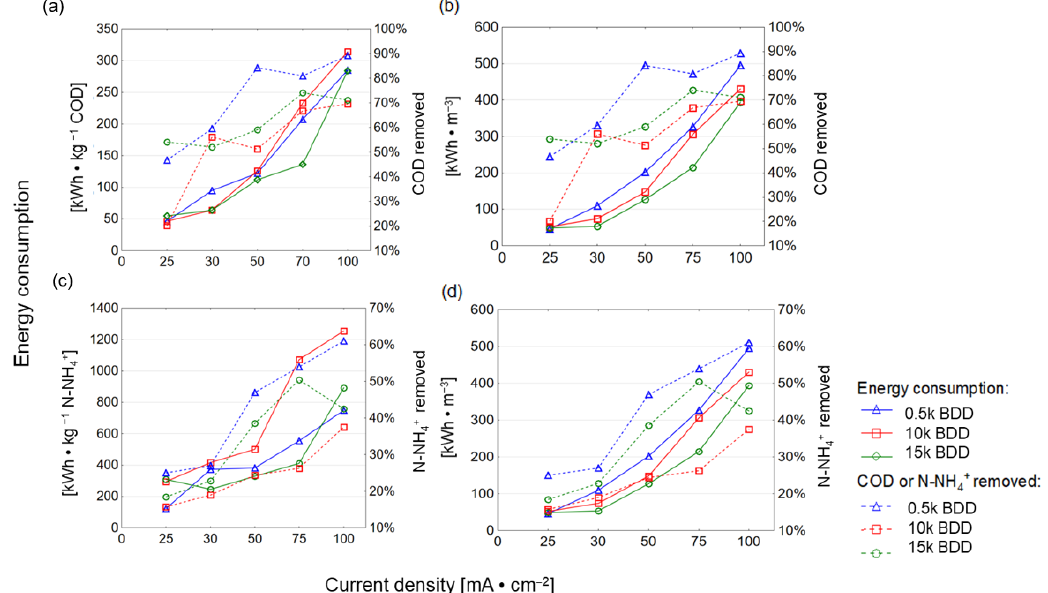
Figure 9. Energy consumption after 8 h of EO process using different BDD/Si electrodes and different current densities plotted against COD removed ( a , b ) and N-NH 4+ removed ( c , d ). For example, Panizza and co-workers [85] indicated an increase in energy consumption with increased j and achieved complete removal of COD after 7 h (flow